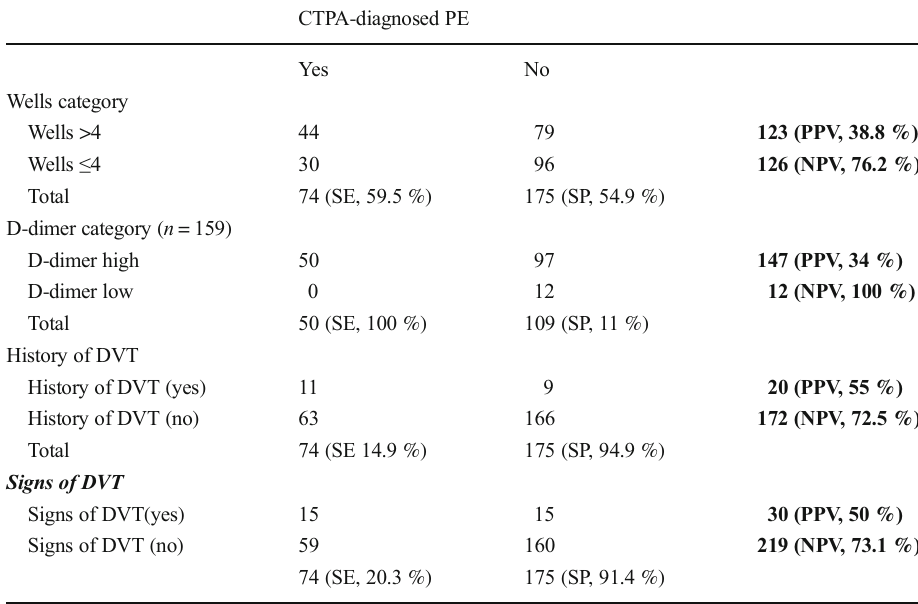
CTPA-diagnosed PE